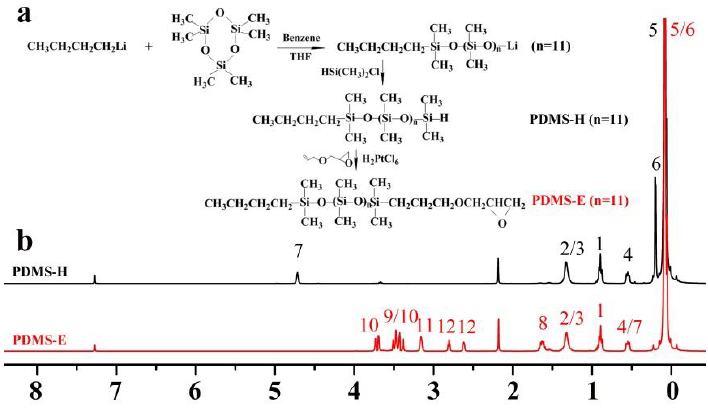
Figure 1. ( a ) Scheme of PDMS-H and PDMS-E polymer synthesis. ( b ) 1 H NMR spectra of PDMS-H and PDMS-E in CDCl 3 at 25 °C.